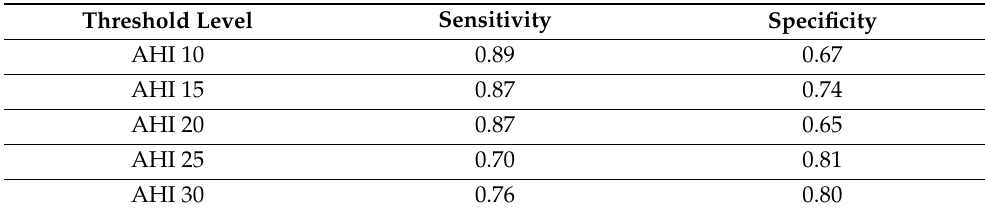
Table 14. Sensitivity and specificity for each AHI level at the output of the correcting block for the operation set point established from the MCC